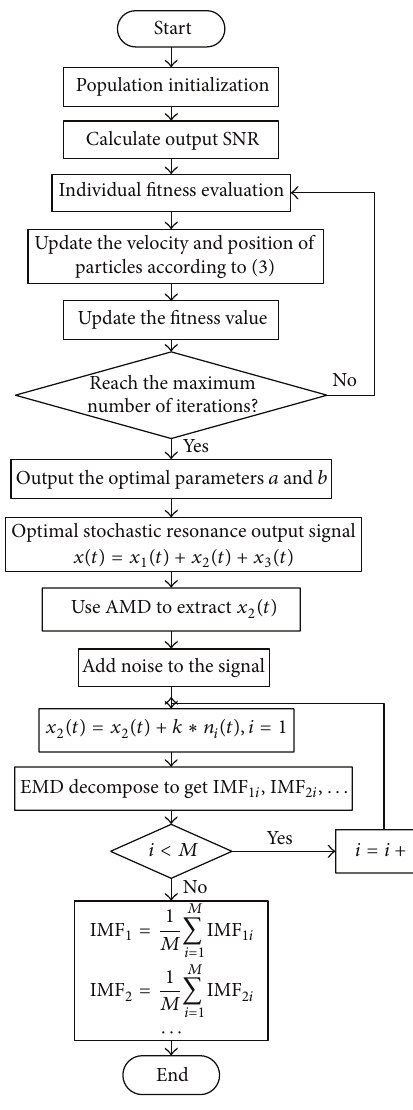
Figure 1: The flow chart of adaptive stochastic resonance and